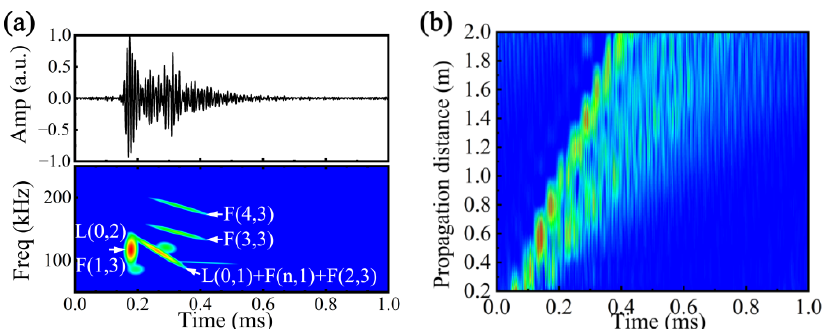
Figure 6. ( a ) Time-frequency diagrams of the UGW synthesized signal at the propagation distance of 0.8 m and ( b ) time domain diagram of the UGW synthesized signal at different propagation